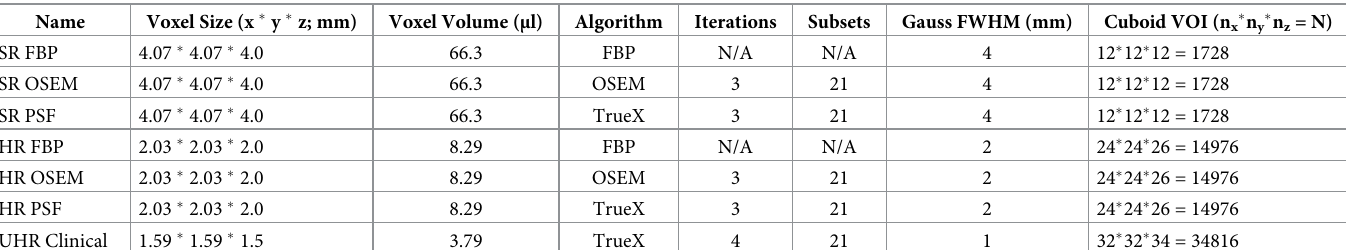
Table 1. Parameters of image reconstruction protocol.